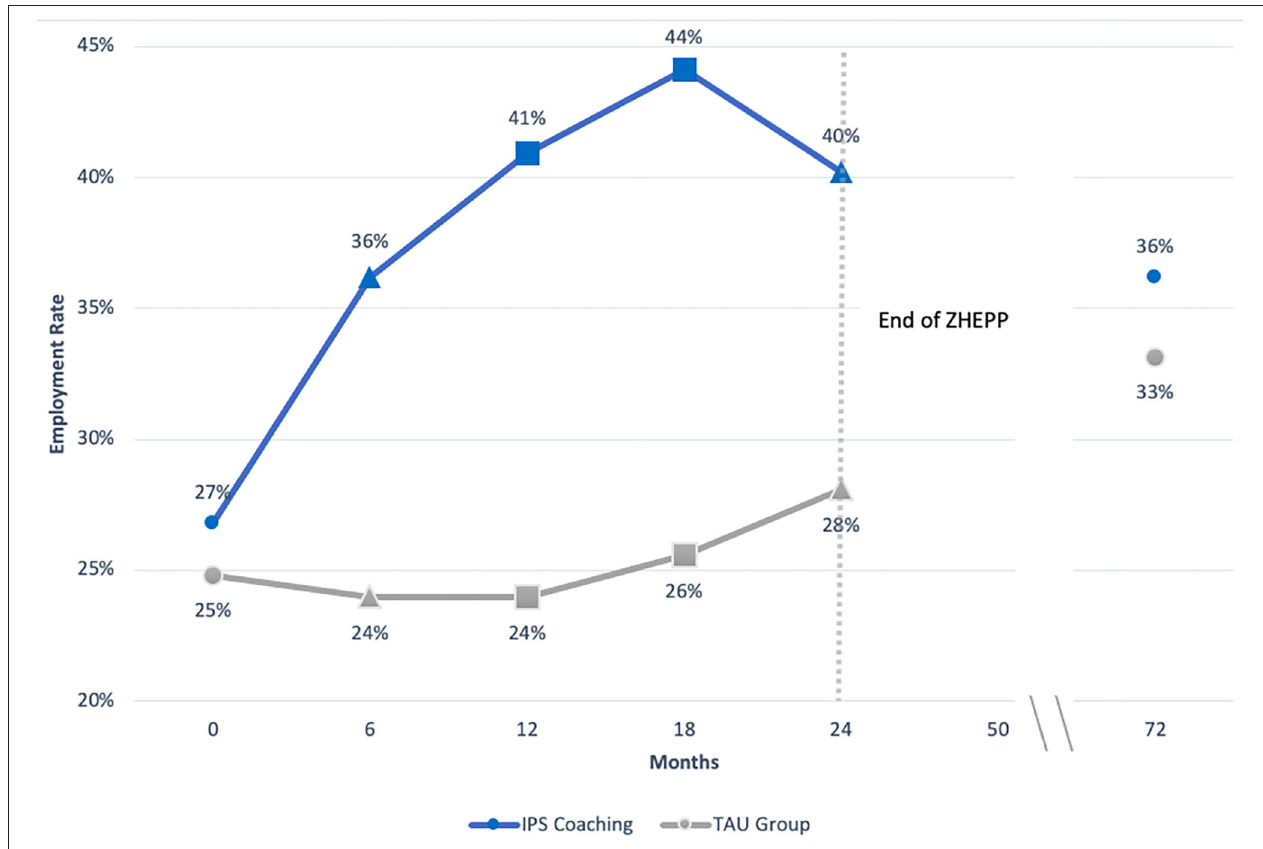
FIGURE 1 | Employment rate in ZhEPP and its follow-up based on intention-to-treat , LOCF analysis. IPS = Individual Placement and Support, M1 = primary job market, TAU = treatment as usual. For participants retired at follow-up time point (72 months after start of study), the values obtained at time point 4 were carried